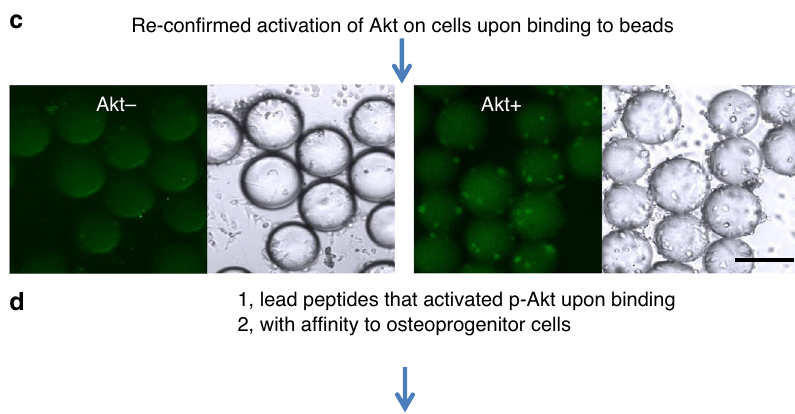
Fig. 1 Schematic for the discovery of osteogenic-speci fi c peptides. a Bone marrow stromal cells (BMSCs) were obtained from mice and maintained in mesenchymal maintenance medium for 2 weeks (~3 passages), switched to osteogenic medium for 3 to 5 days, then incubated with a focused integrin library for 1 h. These bead-bound osteoprogenitor cells (OPCs) were then fi xed and stained for phosphorylated Akt (p-Akt). Positive beads were identi fi ed as displaying both cell binding to the beads and positive p-Akt expression in the cells bound to the beads. b Positive beads from the fi rst screen were identi fi ed, sequenced, and resynthesized. The beads were incubated with osterix + red cells to identify beads with a high af fi nity towards osterix + cells semi-quantitatively. c Positive beads from the second screen were resynthesized and re-incubated with OPCs to con fi rm p-Akt activation. P-Akt was stained green. Some cells on beads were positive for p-Akt. Cells not attached to beads were p-Akt negative. d From the described screening process, YLL3 and YLL8 were selected for decoding and resynthesized for further characterization. All the experiments were repeated at least three times. Scale bar = 100 µ